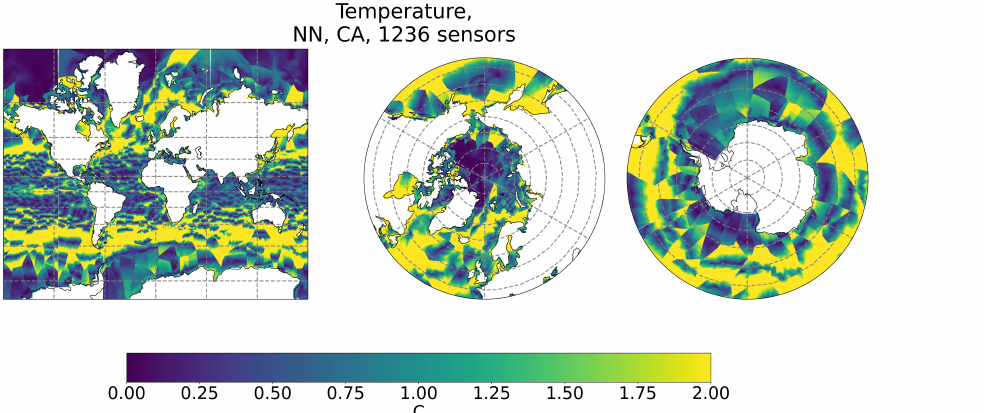
Figure A7. Spatial distribution of reconstruction RMSE by the Nearest Neighbor (NN) method from 1236 measurements with placement using the Concrete Autoencoder